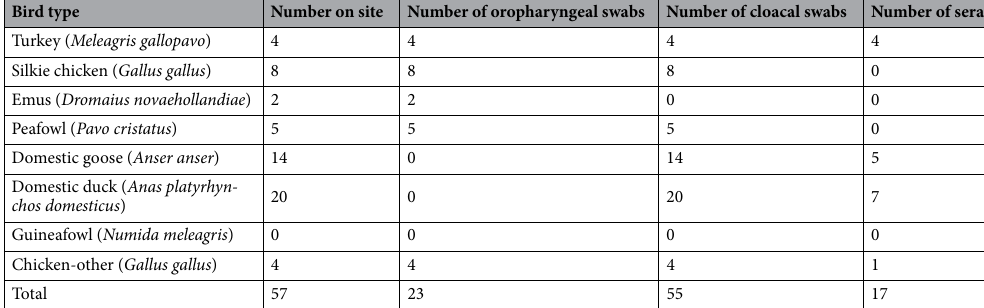
Number on site Number of oropharyngeal swabs Number of cloacal swabs Number of